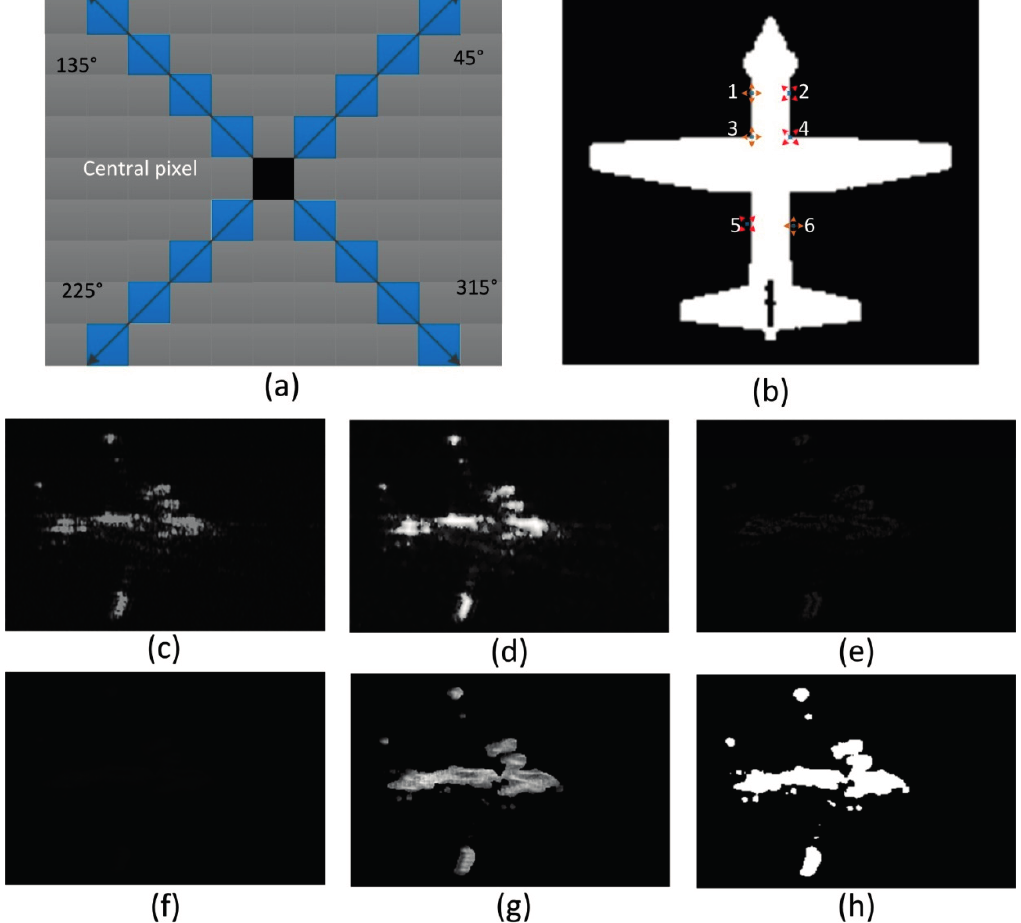
Figure 1. Sketch map of the salient target detection from gradient textural saliency map. ( a ) the sketch map of 4-direction window; ( b ) the sketch map of 4-direction window on target; ( c ) the original image; ( d ) the pre-processed image of ( c ); ( e ) the gradient image of ( d ); ( f ) the gradient textual saliency map of ( e ) ( it shows like black image because the index values of pixels are very small) ; ( g ) the normalized saliency map of ( f ) according to Equation (12) in Section 3.2 ; ( h ) the segmented binary image of ( g